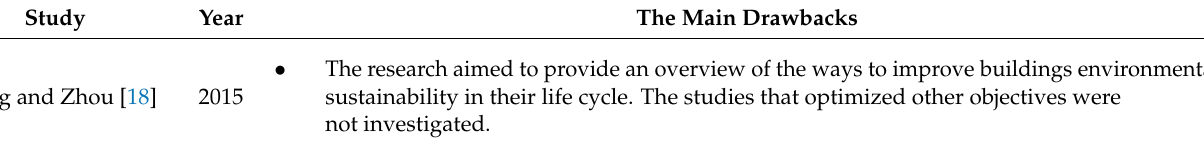
Table 1. List of the recent review studies in the field of building performance optimization